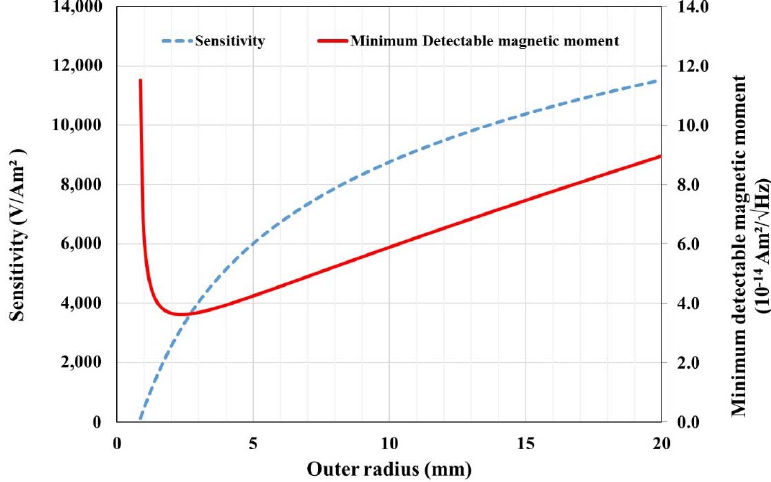
Figure 2. Pick ‐ up coil optimization with sensitivity and minimum detectable moment versus coil outer radius. Inner radius was fixed at 0.8 mm.